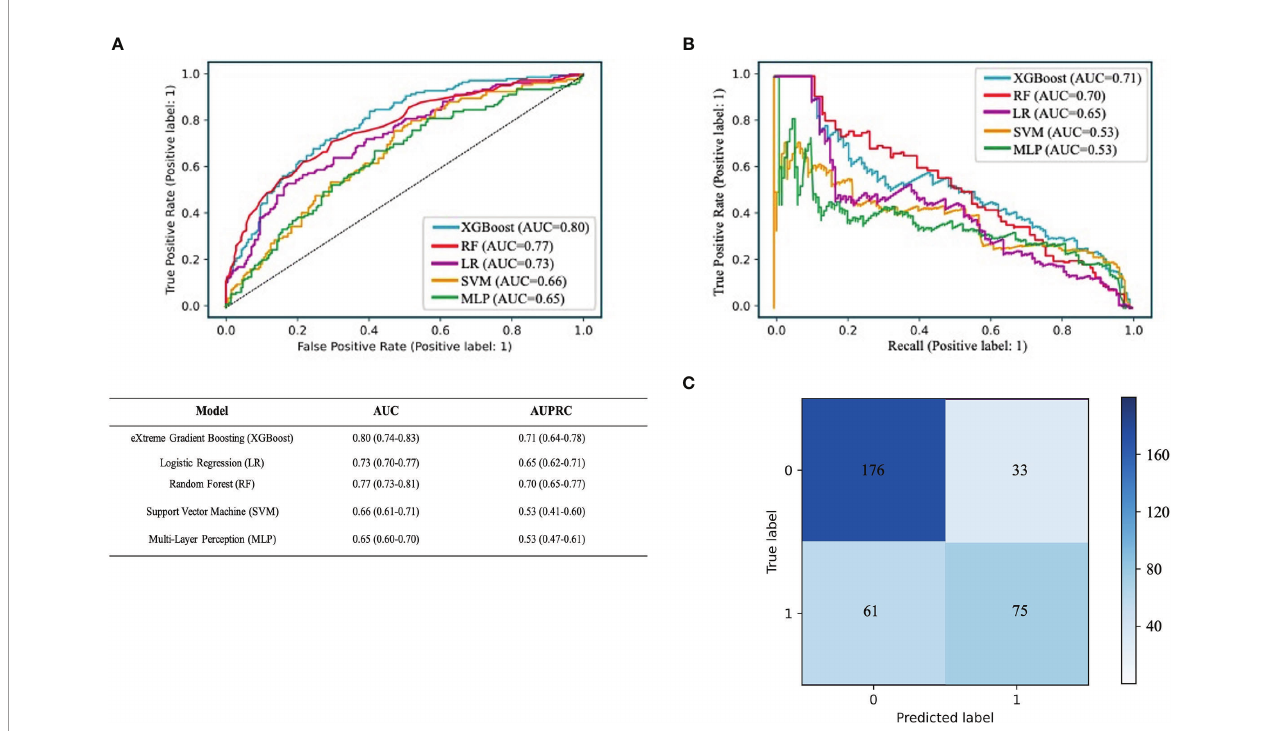
FIGURE 3 | Performance of the predictive models. (A) The ROC curve analysis of various prediction model. (B) The PRC curve of different models. The confusion matrix of XGBoost model in the validation cohort. (C) The confusion matrix of XGBoost model. The confusion matrix was composed of the True negative in the fi rst quadrant, the false negative samples in the second quadrant, the true positive example in the third quadrant and the false positive example in the fourth